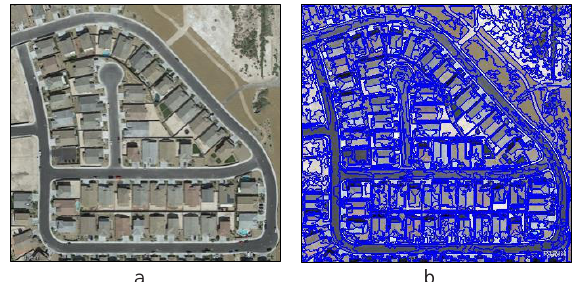
Figure 2. a) High resolution image; b) multi